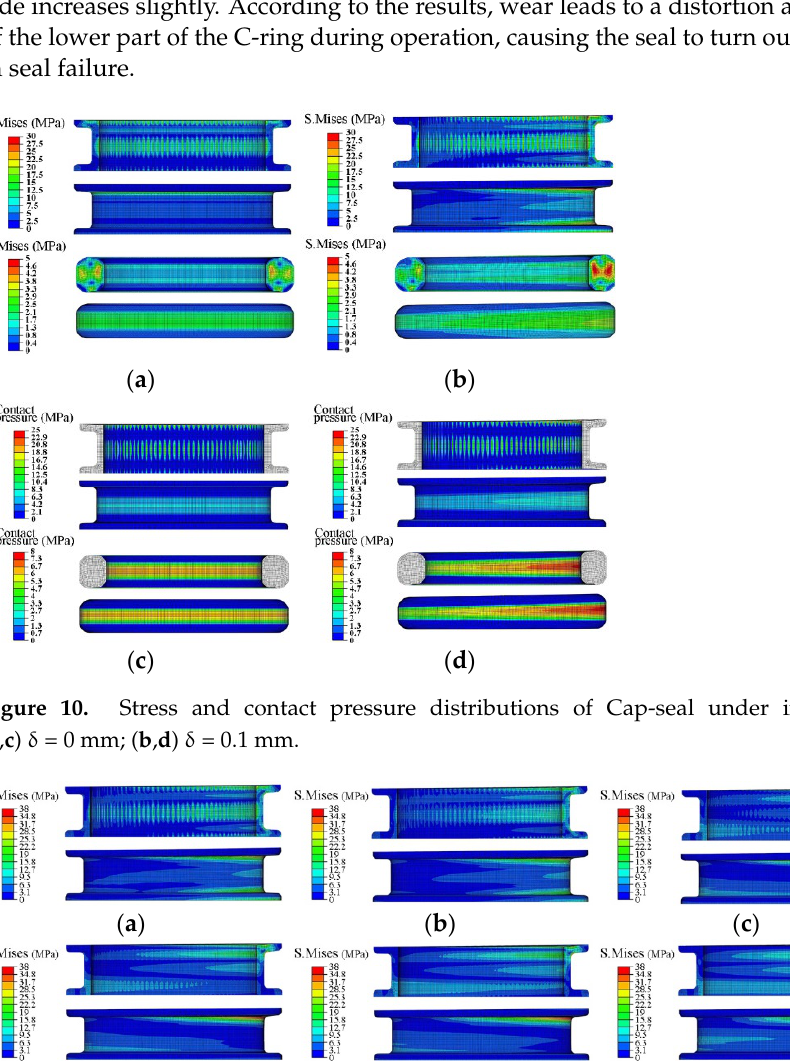
Figure 11. Stress distribution of C-ring under different working distances. ( a ) 0 km; ( b ) 1.8 km; ( c ) 3.6 km; ( d ) 7.2 km; ( e ) 14.4 km; ( f ) 28.8 km.